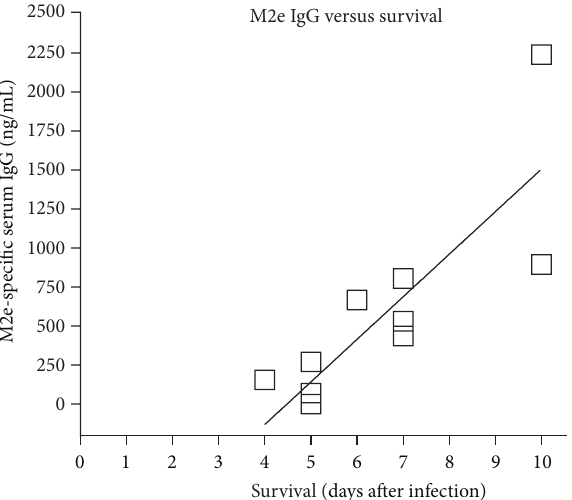
Figure 5: Correlation analysis. M2e-specific serum IgG from birds vaccinated with LL-M2e ( 𝑛 = 12 ) was plotted as a function of survival following infectious challenge. The line represents a linear regression